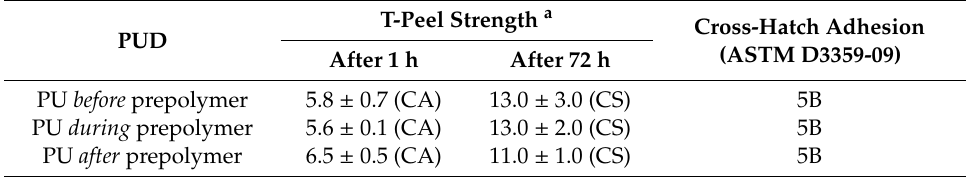
Table 7. T-peel strength values of plasticized PVC/PUD/plasticized PVC joints and cross-hatch adhesion values evaluated according to ASTM D3359-09 standard.